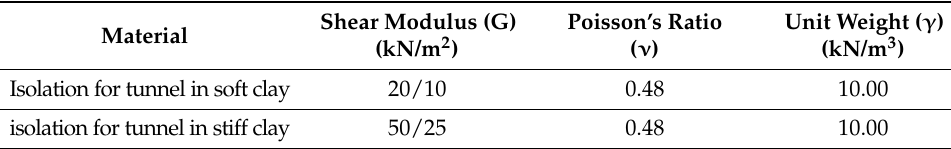
Table 5. Material properties of silicon-based isolation material.